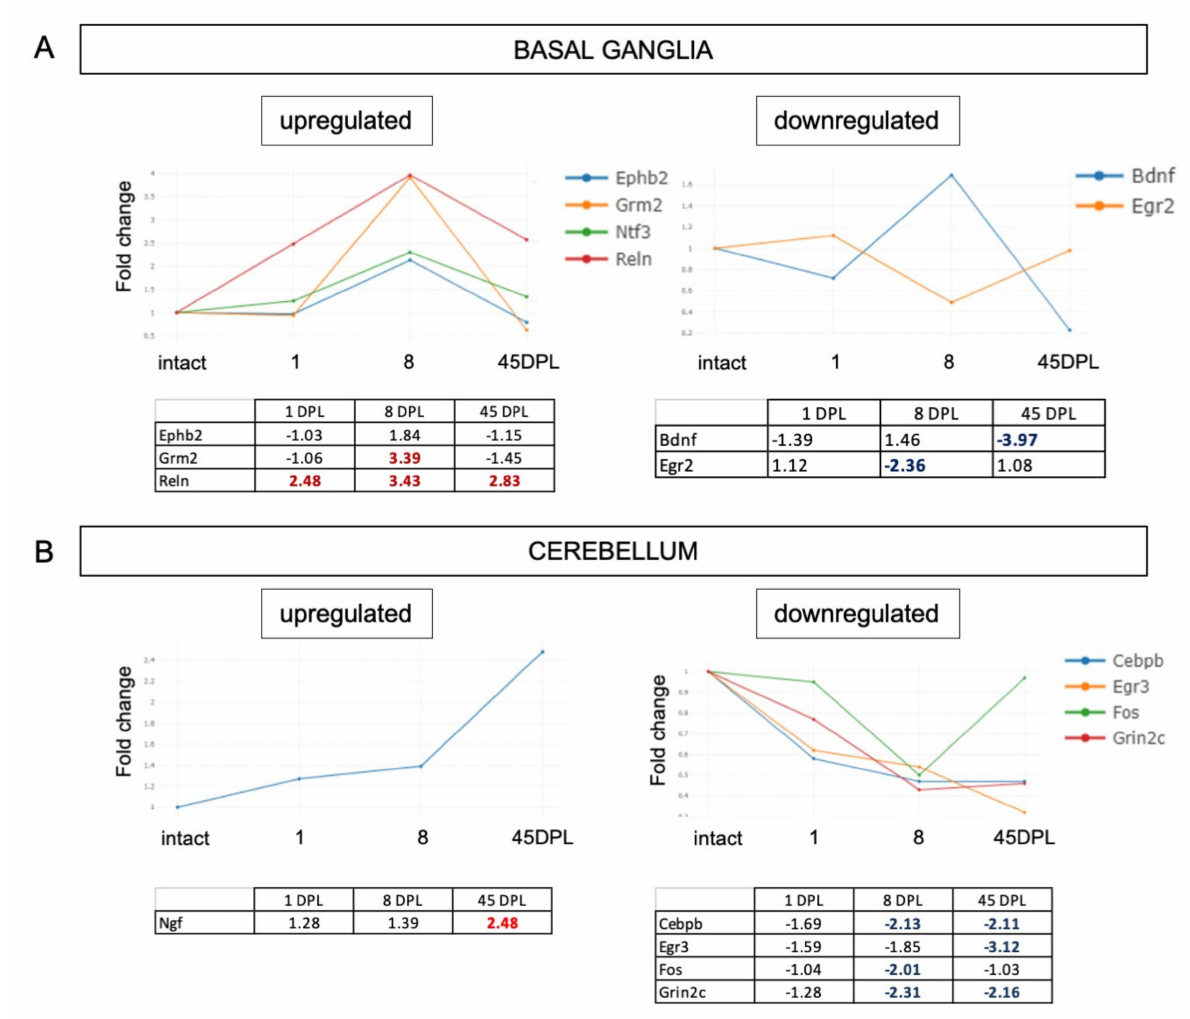
Figure 5. ( A , B ) Time course expression of upregulated and downregulated genes in Basal Ganglia ( A ) and Cerebellum ( B ). Relative gene expression is shown as Fold Change (FC) normalized on respective area from intact animals. Only genes with FC ≥ 2 are included in the